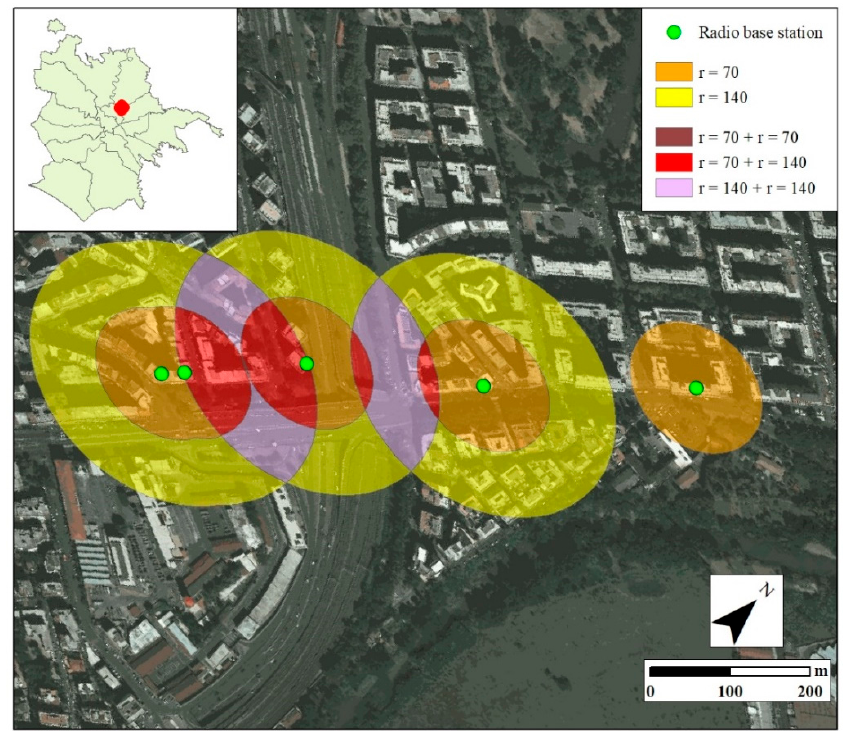
Figure 2. Circular buffer zones (in meters) defined by the alignment of RBS (the same as in Figure 1) in a GIS environment. Source: authors’ elaboration.